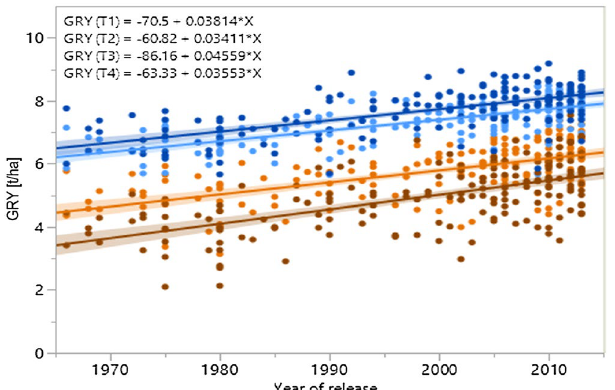
Figure 5. Breeding progress in German winter wheat. Progress of grain yield (GRY) of 178 winter wheat cultivars across 50 years at four treatments (T1 low N, no fungicide orange, T2 low N with fungicide light blue, T3 high N no fungicide brown, T4 high N with fungicide dark blue) based on LSmeans (treatment-specific, over years and repeats). Trendlines of GRY progress are given of all treatments, each with 95% confidence interval. Equations of all trendlines are given above each